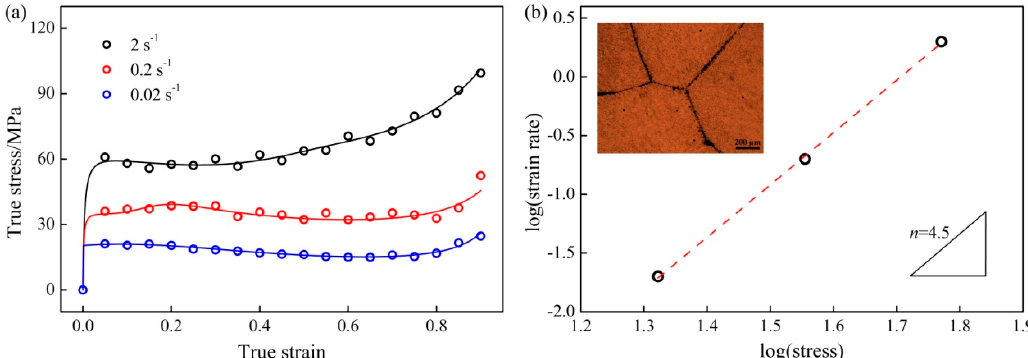
Figure 1. ( a ) Flow curves of the Ti-40Al-10V alloy at 1300 °C under various strain rates. ( b ) The relationship between strain rates and flow stresses corresponding to a true strain of 0.1. The inserted optical image is the microstructure of the alloy after heat treatment at 1300 °C for 3 min, followed by quenching.